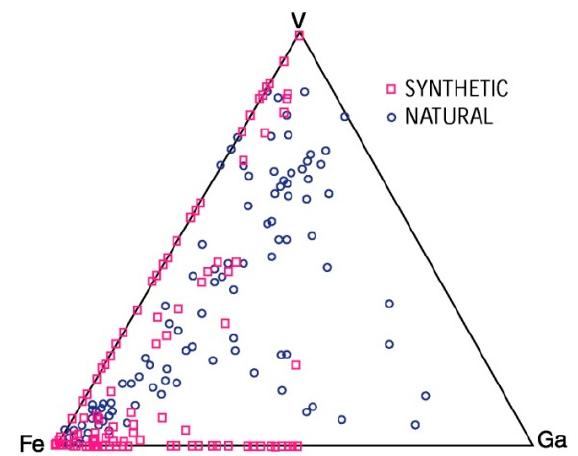
Figure 15. Gallium (Ga)–vanadium (V)–iron (Fe) ternary showing the distinction between natural and synthetic rubies, modified from [67]. synthetic rubies, modified from